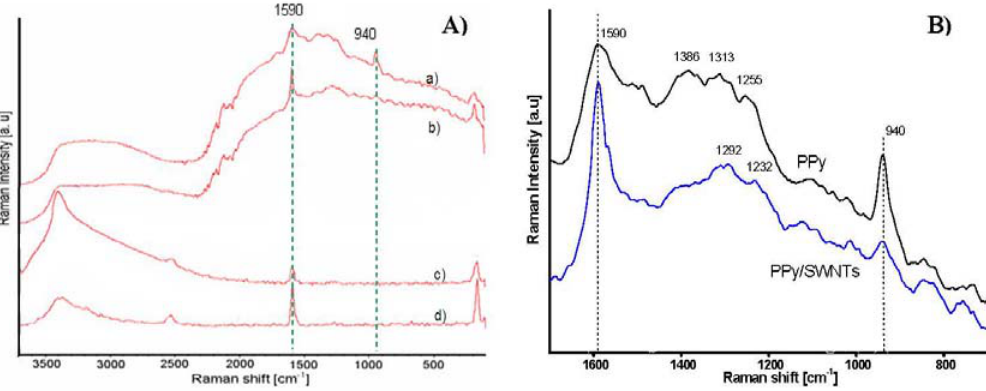
Figure 4. ( A ) Raman spectra of PPy (a), PPy/SWNTs (b), SWNTs (c), purified SWNTs (d) at 1,064 nm laser excitation; ( B ) Raman spectra of PPy and PPy/SWNTs in fingerprint spectral